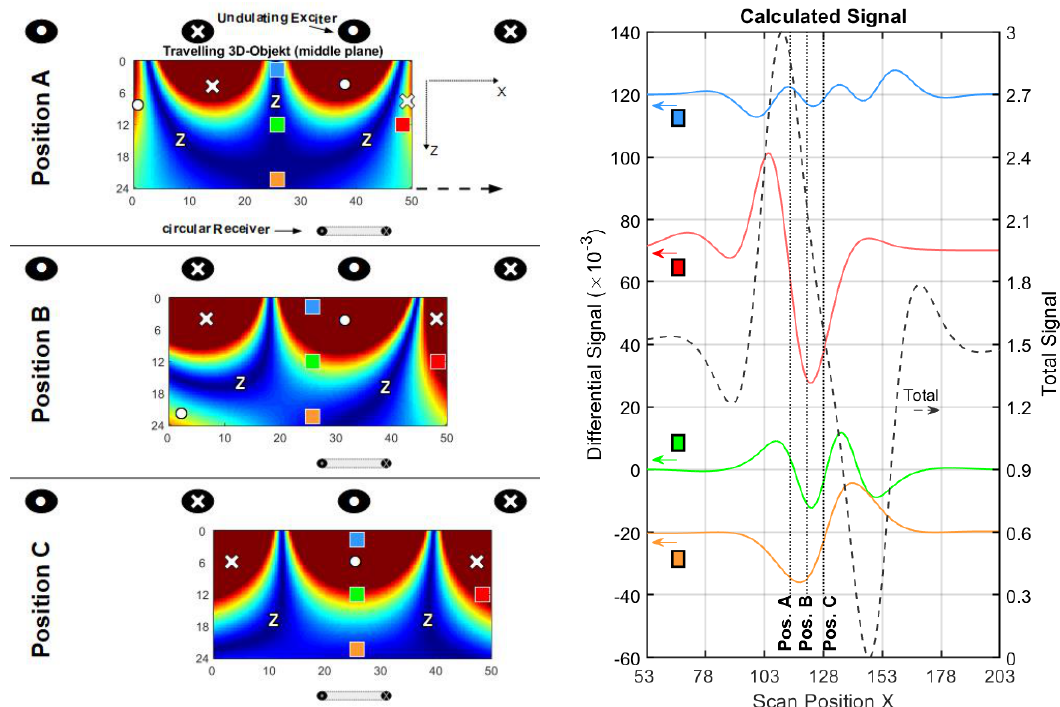
Figure A8. Current and signal calculations with an undulator exciter and a circular receiver; (left) Eddy current distribution in the horizontal middle plane of a conducting volume. Local voids at four characteristic positions (blue, green, orange and red squares) are analyzed; (right) Total signal (dotted black) and differential signals (blue, green, orange and red lines) for the four voids. Table A3. The main results from the calculated signals shown in Figure A8. Total Signal Edge Diff. Signal Center Diff. Signal Edge (max. amplitude) (max. amplitude) (max. amplitude) (max. amplitude) (max. amplitude) 1 The ratio between the differential signal and the total signal.